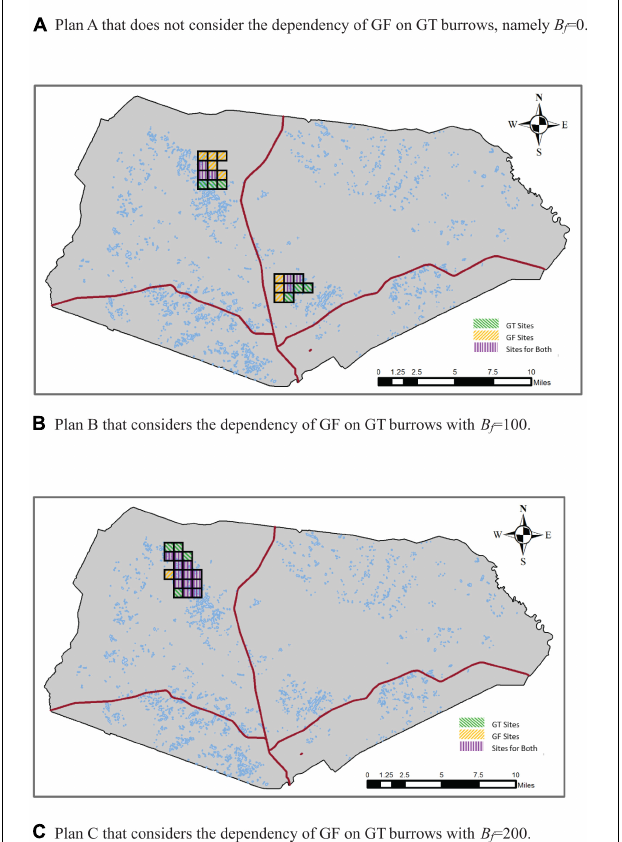
FIGURE 2 | Selection results of alternative conservation plans with r s = 2, P f = 40, and B t = 700. (A) Plan A that does not consider the dependency of Gopher Frog (GF) on GT burrows, namely B f = 0. (B) Plan B that considers the dependency of GF on GT burrows with B f = 100. (C) Plan C that considers the dependency of GF on GT burrows with B f = 200.